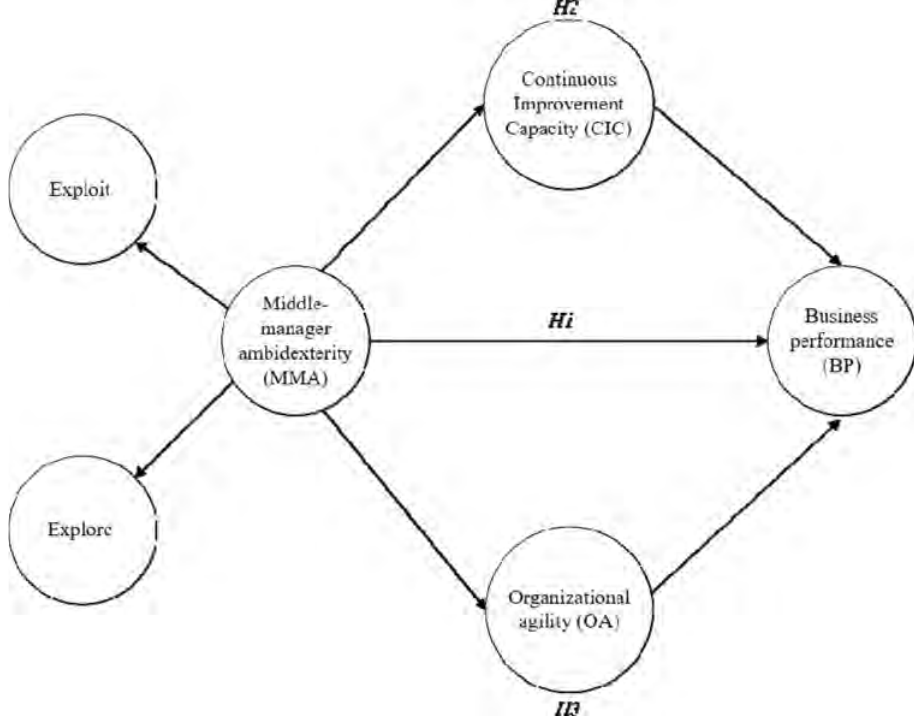
Figure 1. Research